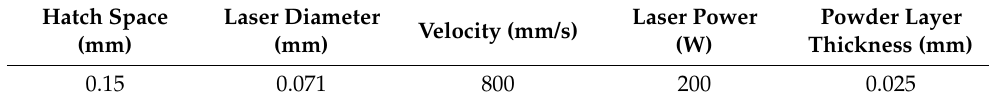
Table 2. Process parameters.